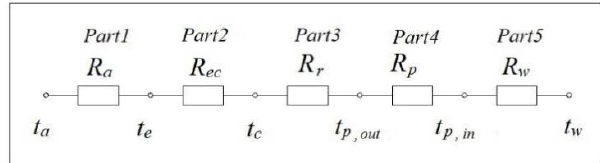
Figure 6. Diagram of the heat transfer process.